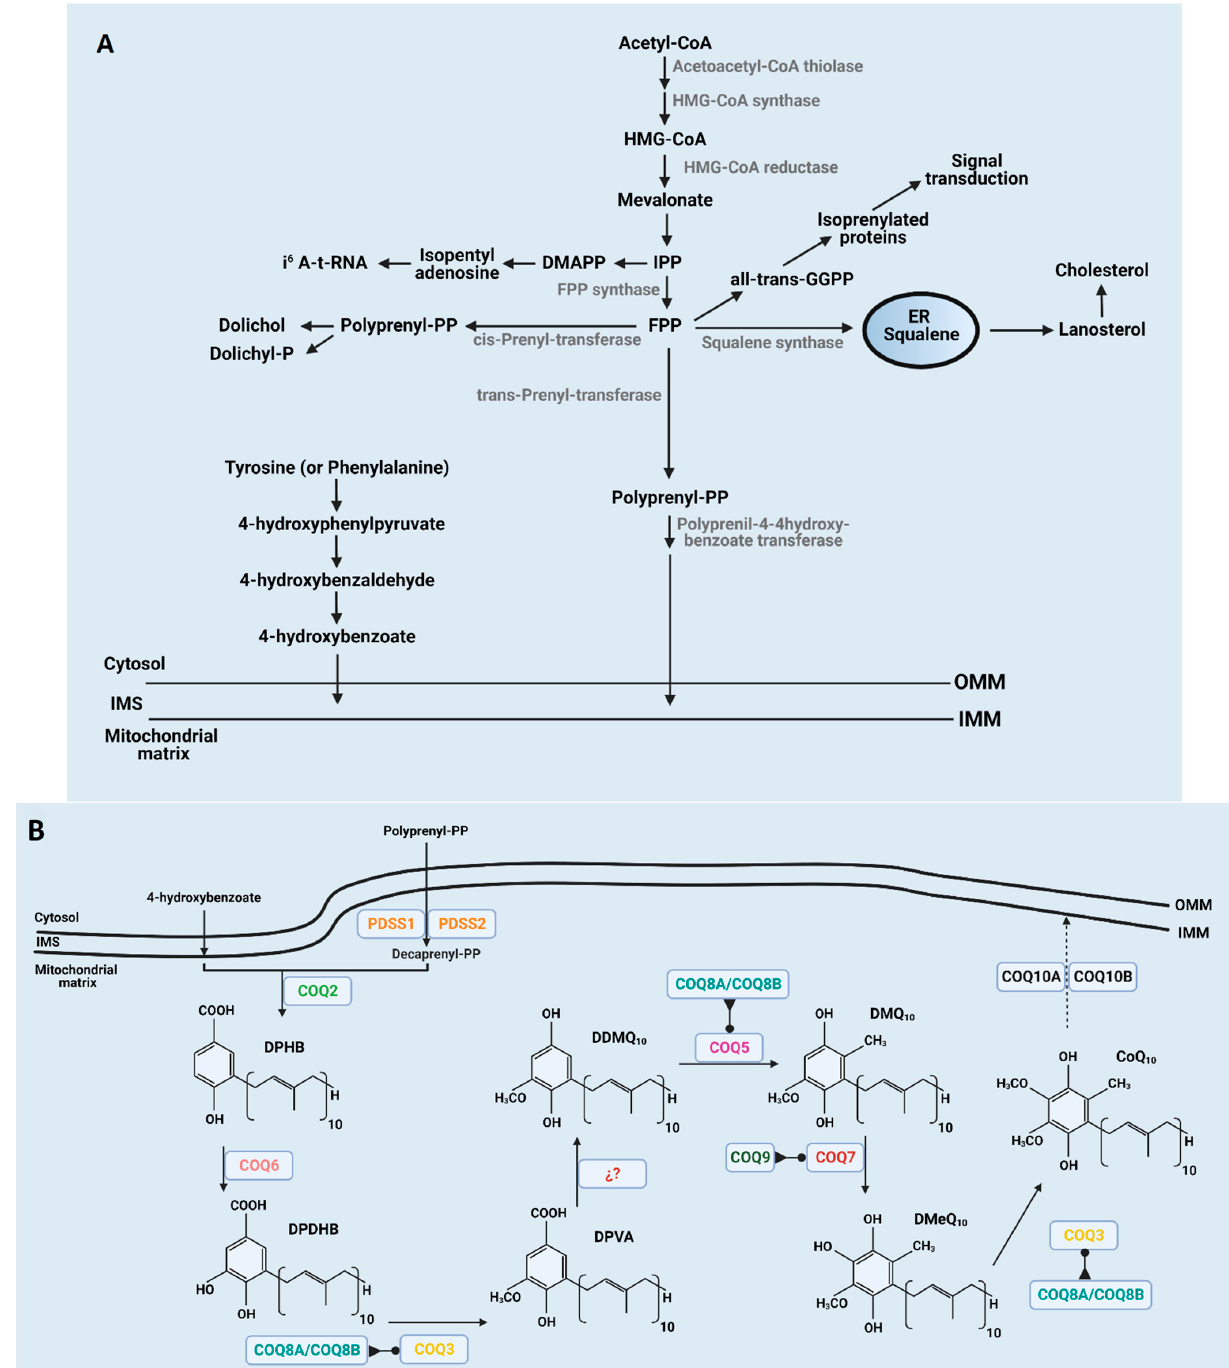
Figure 1. Scheme of CoQ synthesis in mitochondria. ( A ) Synthesis of the mevalonate chain in the ER and quinone head processing from tyrosine in cytosol or mitochondrial matrix. ( B ) Assembly of benzene ring and isoprenoid tail at the inner mitochondrial membrane and further modifications of the phenol head at the inner mitochondrial membrane. Members of the CoQ-synthome are indicated in each step. In some cases, the enzyme involved in some of the steps are unknown. Regulatory enzymes such as COQ8 and COQ9 are indicated at the steps in which they are actively